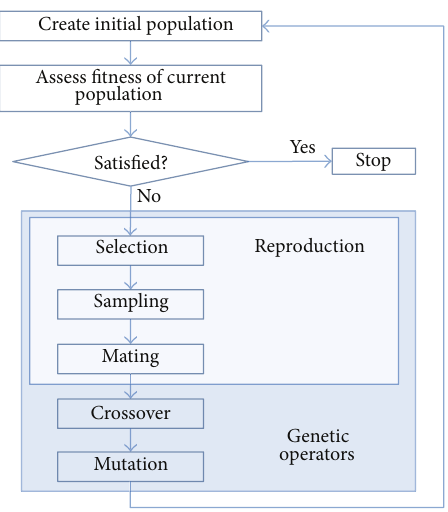
Figure 1: Genetic algorithm process